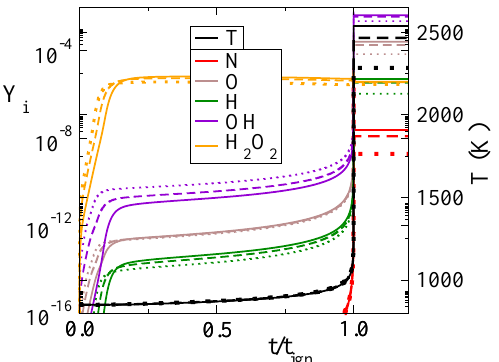
Figure 4. Evolution of species mass fraction against scaled time (t/t ign ) with various H 2 O percentages (0%: solid lines, 20%: dashed lines and 50%: dotted